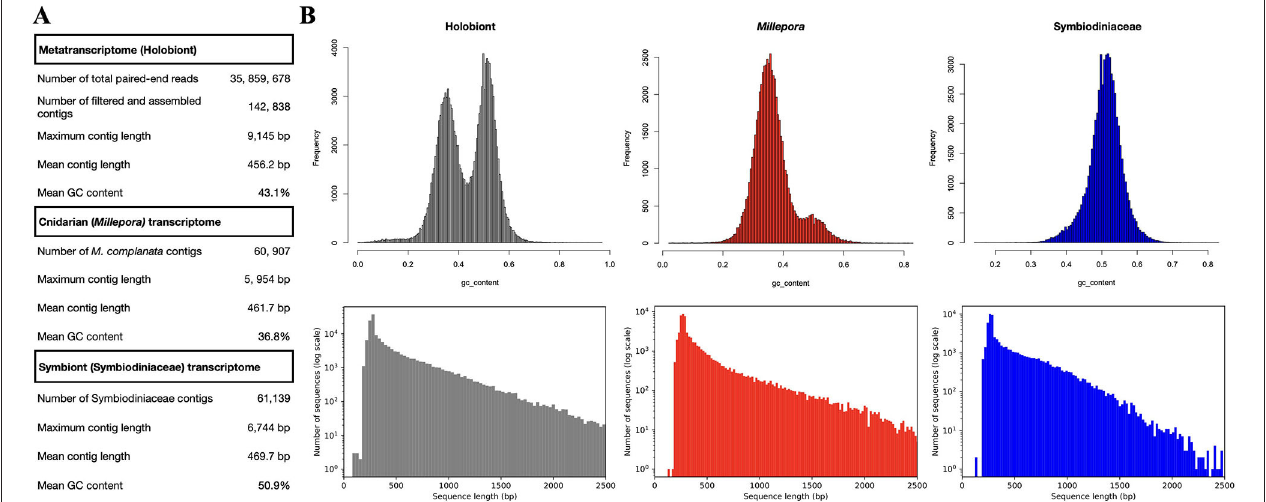
FIGURE 1 | (A) M. complanata’s metatranscriptome assembly statistics. (B) Relative contribution of M. complanata and Symbiodiniaceae algae to the assembly (differences in GC content and sequence length from split sequences). Millepora alcicornis (ID GFAS01, BIOPROJECT PRJNA344421)